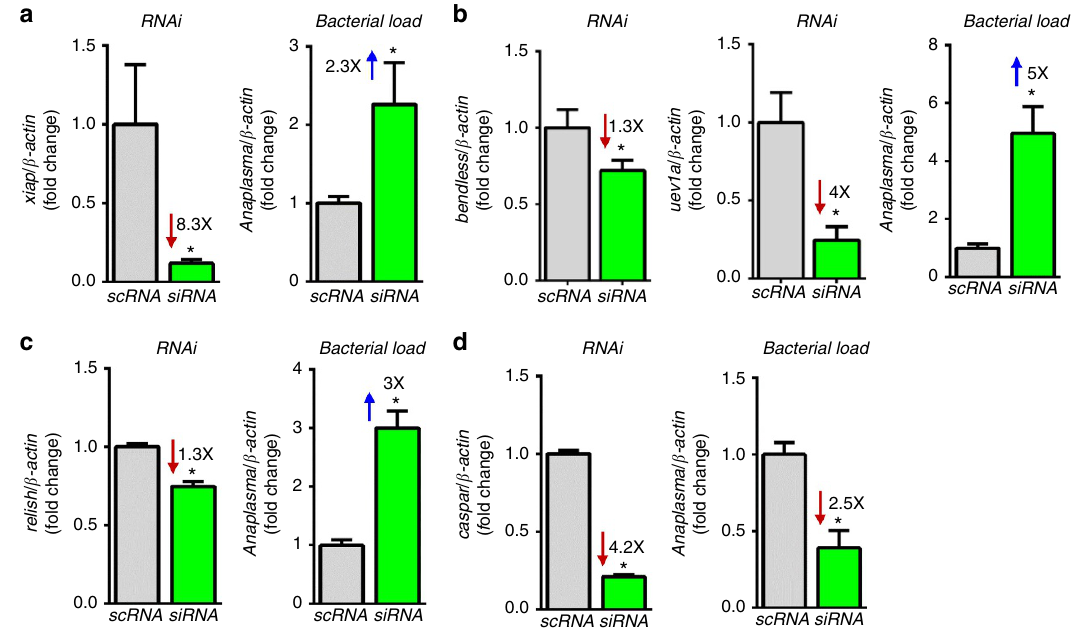
Figure 3 | The I. scapularis IMD pathway responds to A. phagocytophilum infection. ( a – d ) ISE6 (1 (cid:3) 10 5 ) cells were infected with A. phagocytophilum (MOI 50) following targeted gene silencing of ( a ) xiap , ( b ) bendless / uev1a , ( c ) relish and ( d ) caspar . Gene silencing and A. phagocytophilum load (16s rDNA) were measured by quantitative reverse transcriptase–PCR at 18h post-infection in ISE6 cells. Replicates of 5 were expressed as means ± s.e.m. All experiments shown are representative of five biological replicates with two technical replicates each. Student’s t test. * P o 0.05. scRNA, scrambled RNA; siRNA, small interference RNA. See also Supplementary Table